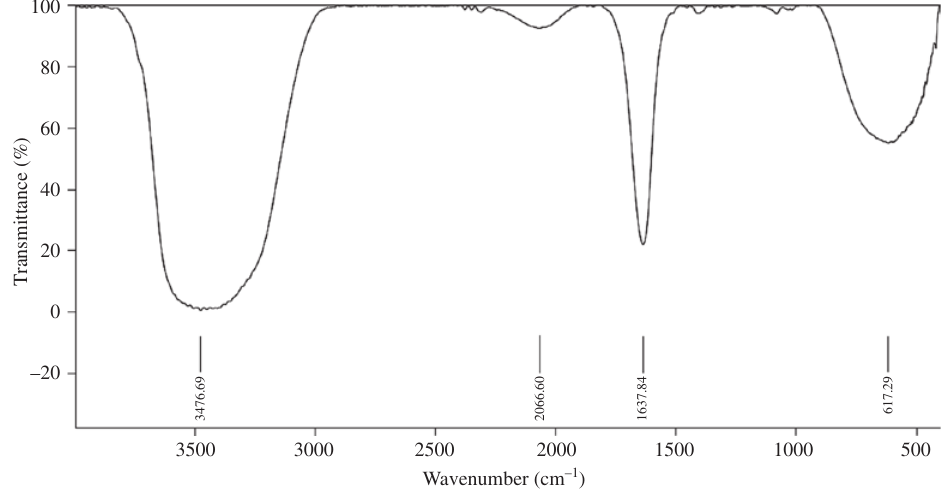
Figure 1: FT-IR spectrum of mushroom extract.